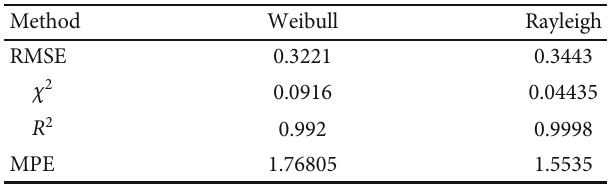
Table 2: Summary of the statistical analysis of wind speed by Weibull and Rayleigh.